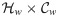
Model-Data comparison of simulated and observations-based GPP over the European continent.Colour-coded Hw×Cw (top right), as obtained from (top left) MTE-MR, (bottom left) JSBACH, and (bottom right) LPJmL. The causal information planes illustrating the point densities are given in the insets.